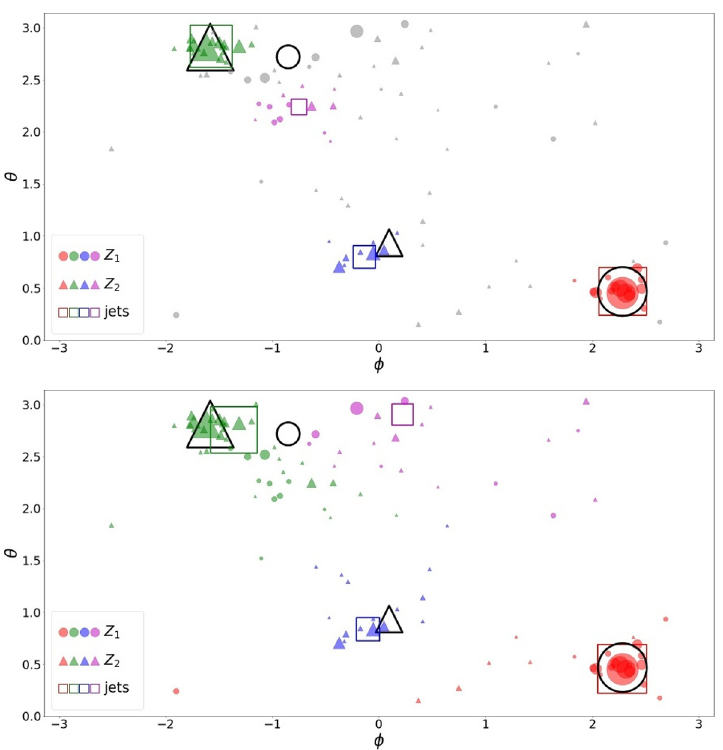
Figure 1 . An illustration of information deformation and loss in jet clustering. One representative e (cid:0) e + ! Z q Z q event is projected to the (cid:30) (cid:0) (cid:18) plane, without any detector e(cid:11)ects. For jet clustering, the anti- k t algorithm with (cid:1) R = 0 : 5 is applied in the upper panel and the ee (cid:0) k t algorithm in the bottom panel. In both panels, each solid symbol represents a particle visible to the detector, with its size scaling with energy, its color denoting the relevant jet, and its shape (circle and triangle) labeling its parent Z boson. The grey symbols in the upper panel represent the particles not clustered to any jets. We use un(cid:12)lled symbols, i.e., colored boxes and black circles and triangles, to represent the jets and their ancestral quarks,